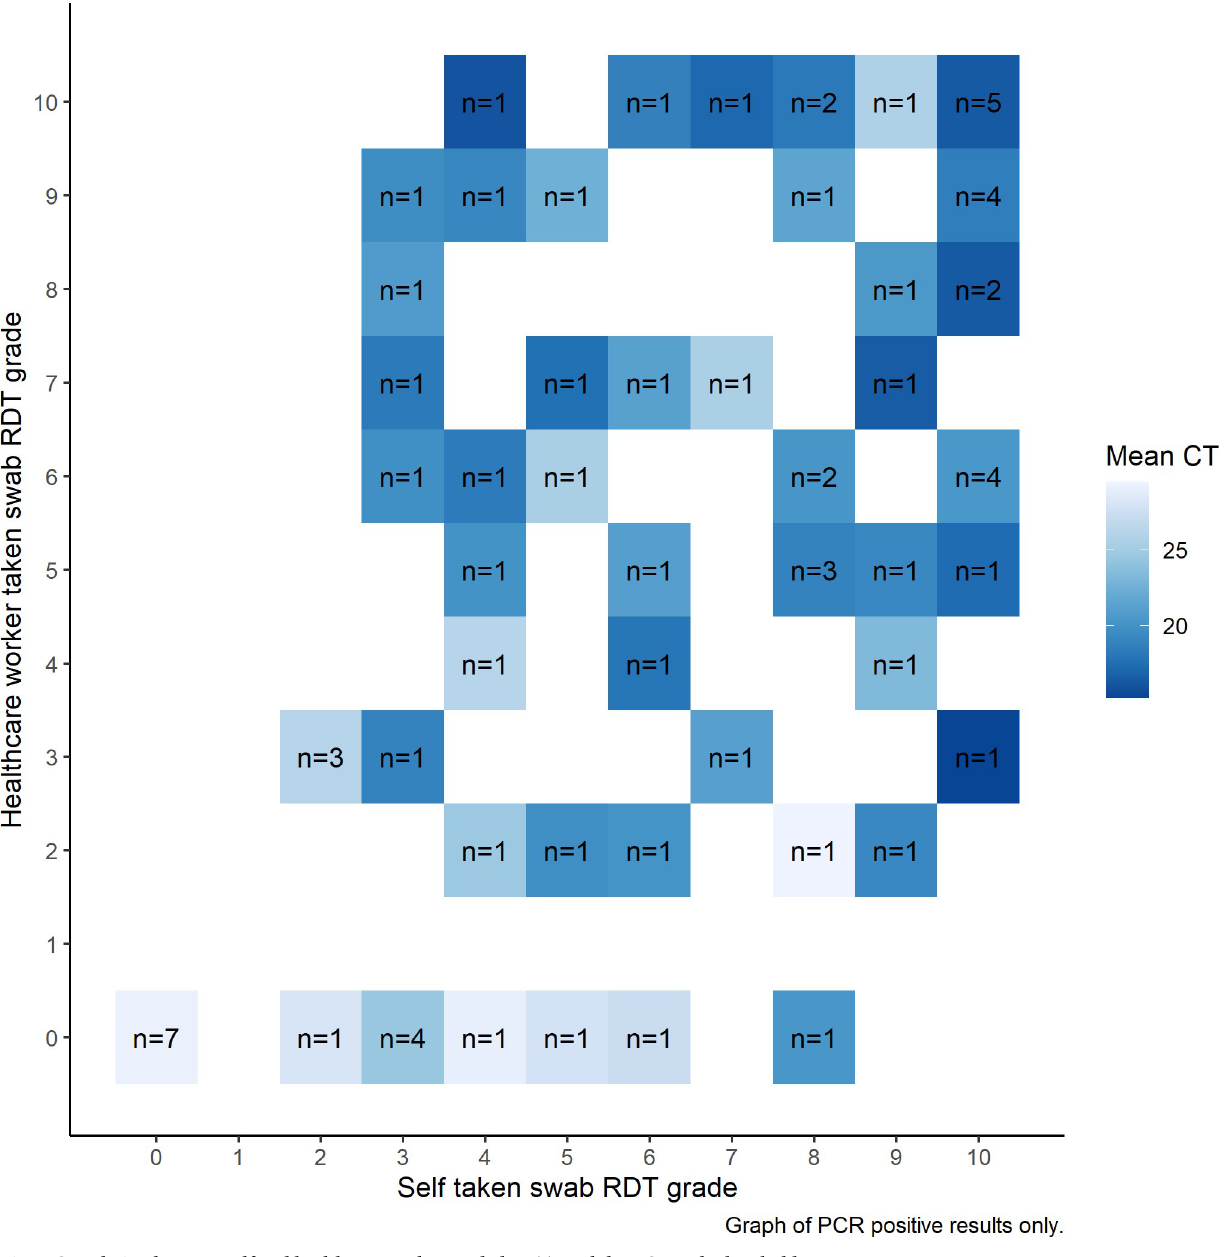
Fig 1. Correlation between self and healthcare worker graded RDT result by PCR cycle threshold.